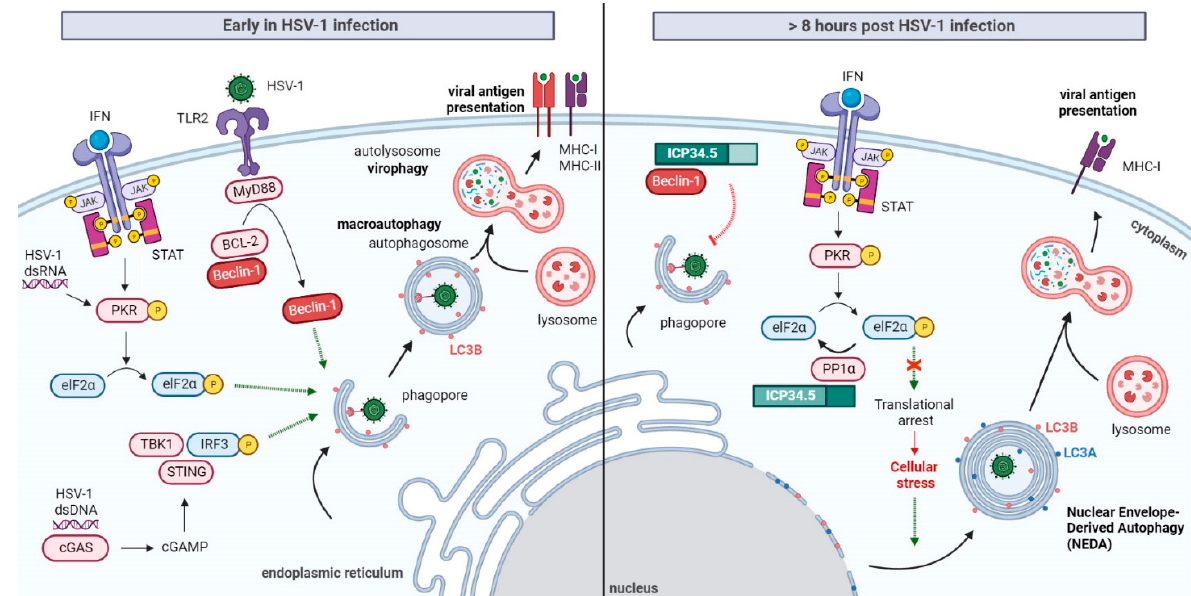
Figure 4. Autophagy modulation by ICP34.5 in HSV-1 infection. Early in HSV-1 infection, detection of the virus by host cell promotes the stimulation of macroautophagy. This pathway may act as a cellular defense mechanism involved in virophagy and the processing of viral antigen for MHC presentation. Autophagic flux can be induced in manner that is dependent on viral gene expression by the PKR/elF2 α pathway. Autophagy may be enhanced through the recognition of PAMPs by the surface receptor TLR2. Activated TLR2 recruits the adaptor MyD88, which causes the dissociation of Beclin-1 from the BCL-2 inhibitory complex, resulting in the induction of autophagy. Finally, HSV-1 dsDNA may be recognized by the cytosolic dsDNA-sensing cGAS, which produces cGAMP to activate STING and TBK1. Activation of TBK1 promotes autophagy stimulation.